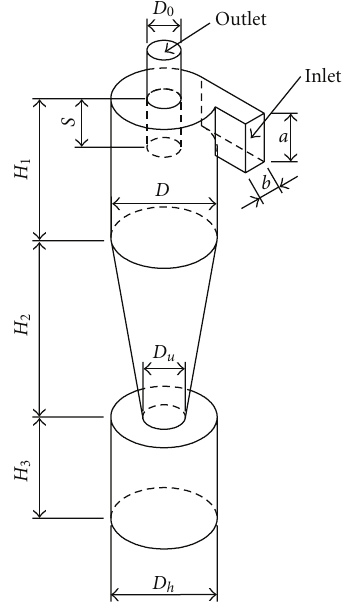
Figure 1: Geometry of conventional cyclone.